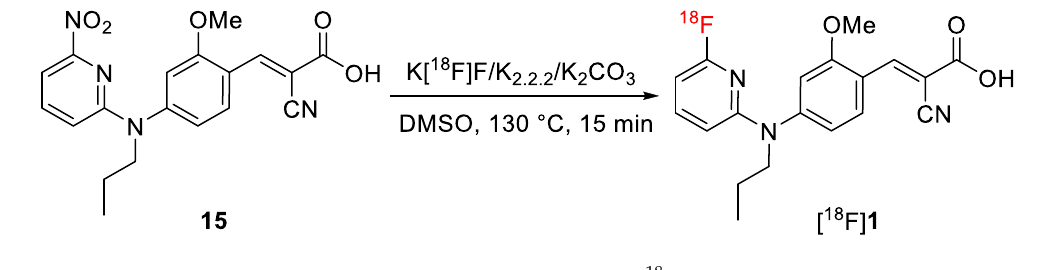
Table 1. Calculated physicochemical parameters of our drug candidates and structurally related compounds. 1